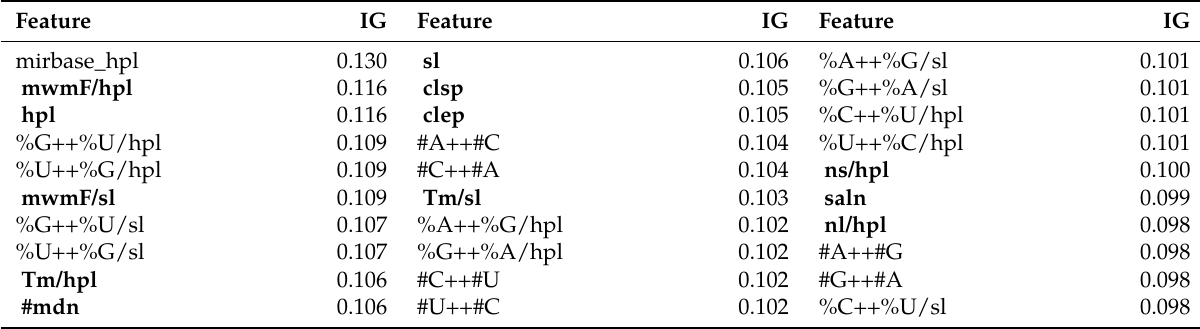
Table 1: Features and their corresponding information gain scores enabling the separation between high confident and low confident miRBase